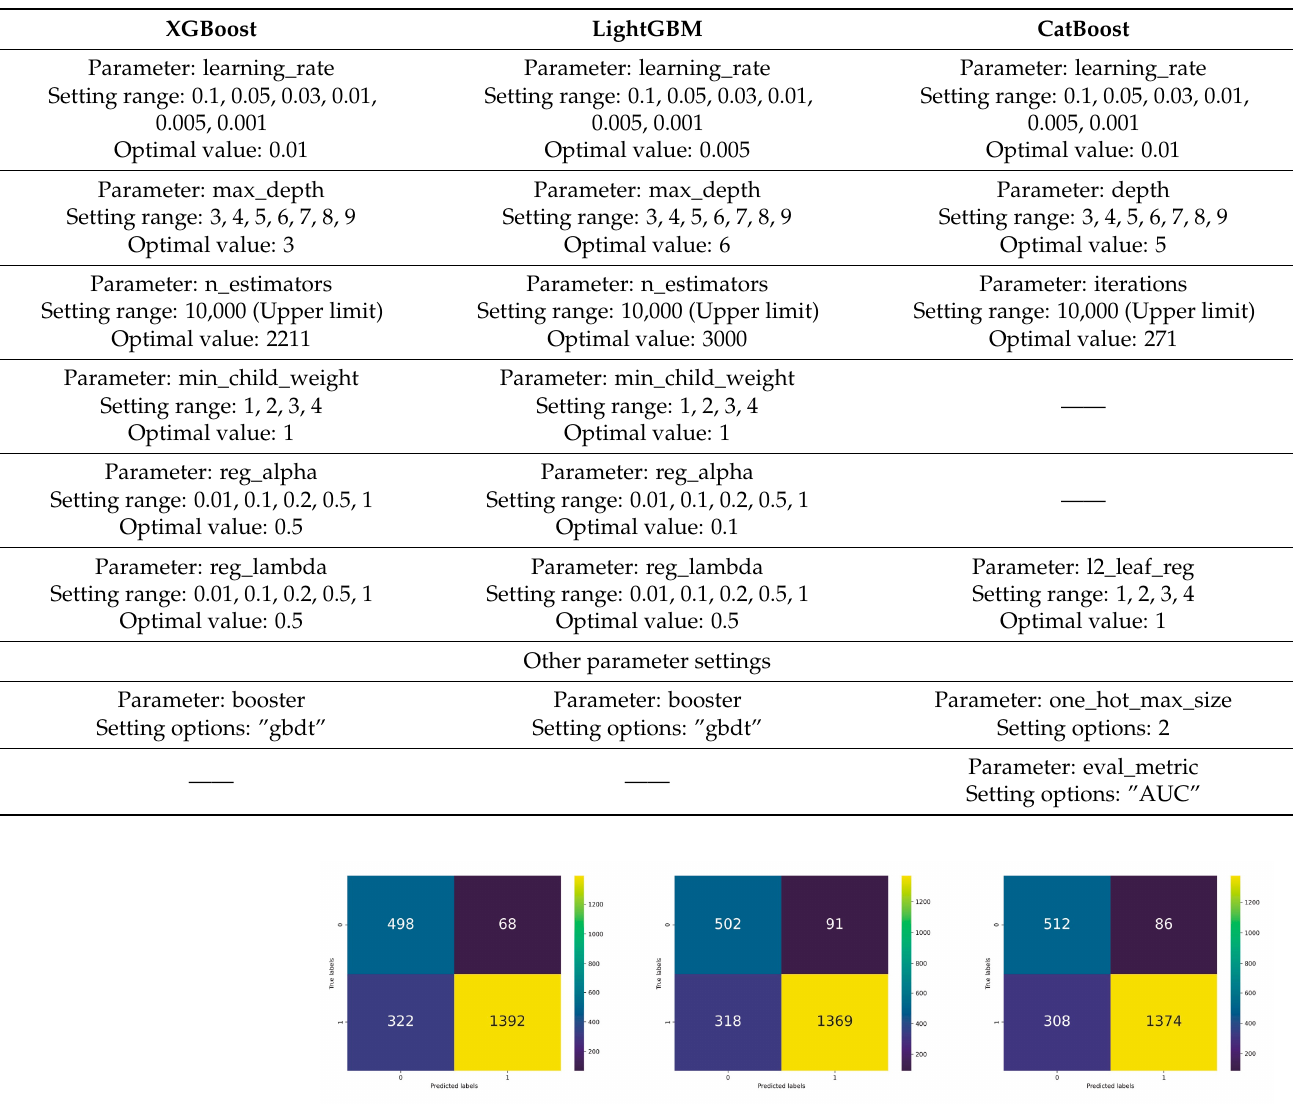
Table 3. Grid search parameter settings and results.